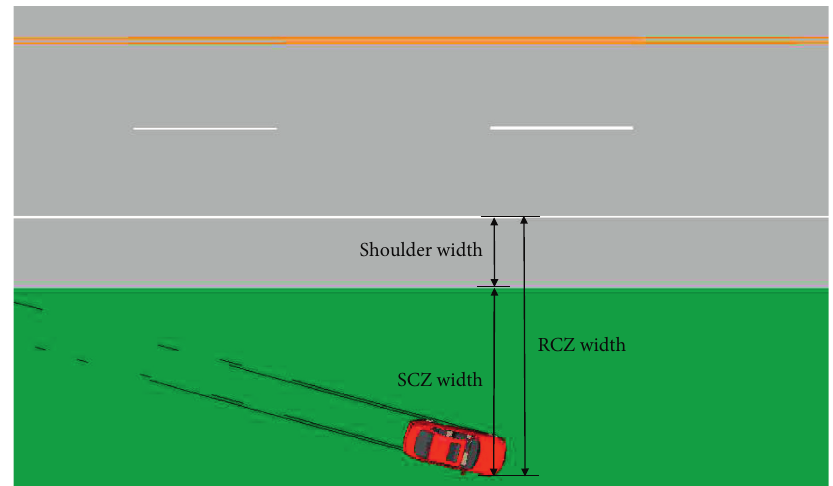
Figure 7: Definition of RCZ width.